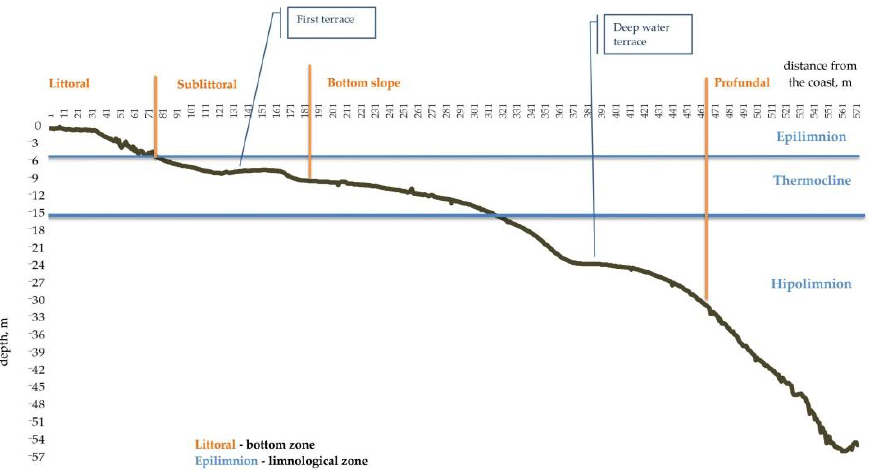
Figure 2. The basin profile of Lake